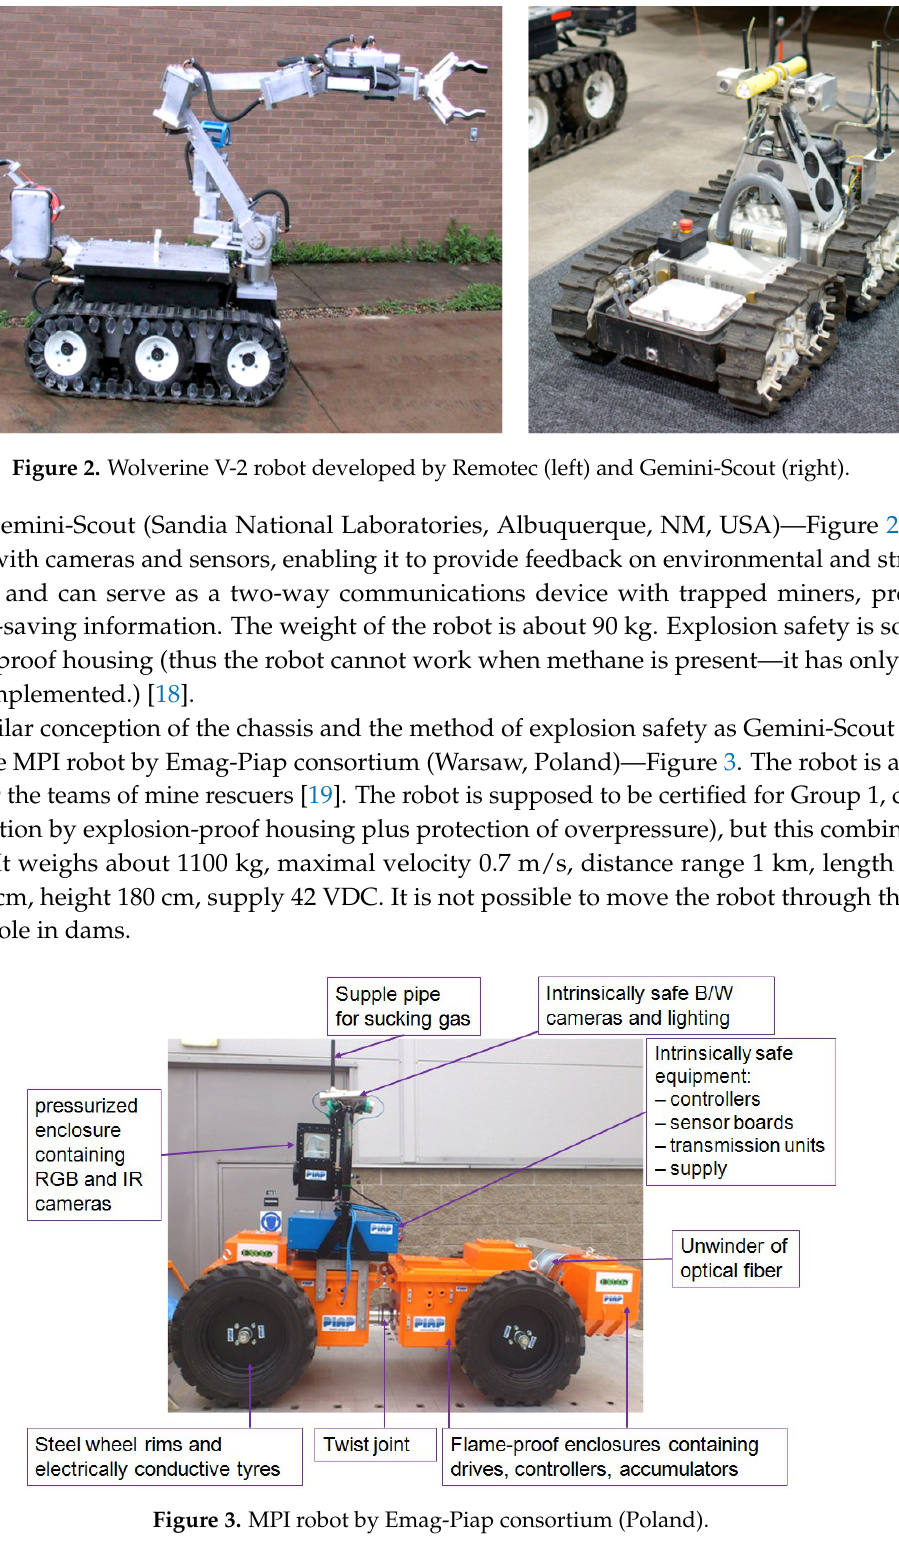
Figure 3. MPI robot by Emag-Piap consortium